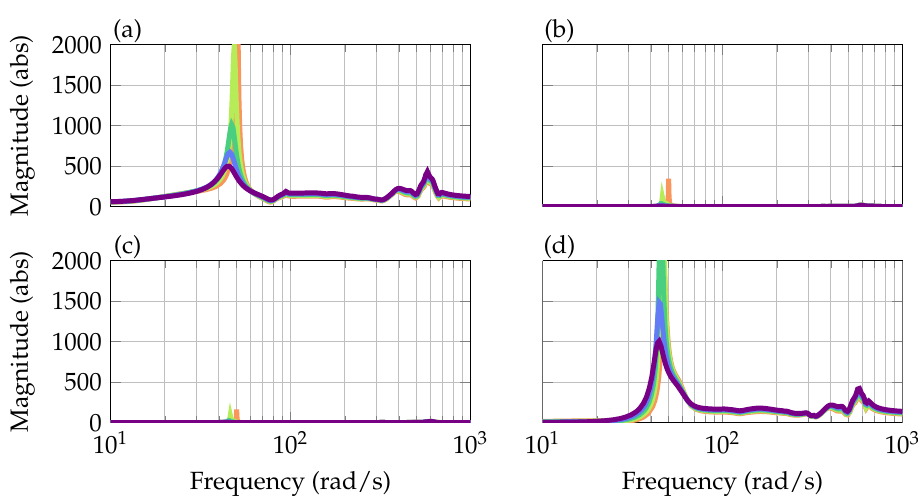
Figure 6. Bode-magnitude plots from virtual inputs to virtual outputs illustrating the decoupling of the unstable symmetric bending mode ( a ) from the unstable asymmetric bending mode ( d ) via the negligible contributions in the cross-coupling channels depicted in ( b , c ). The plots are shown